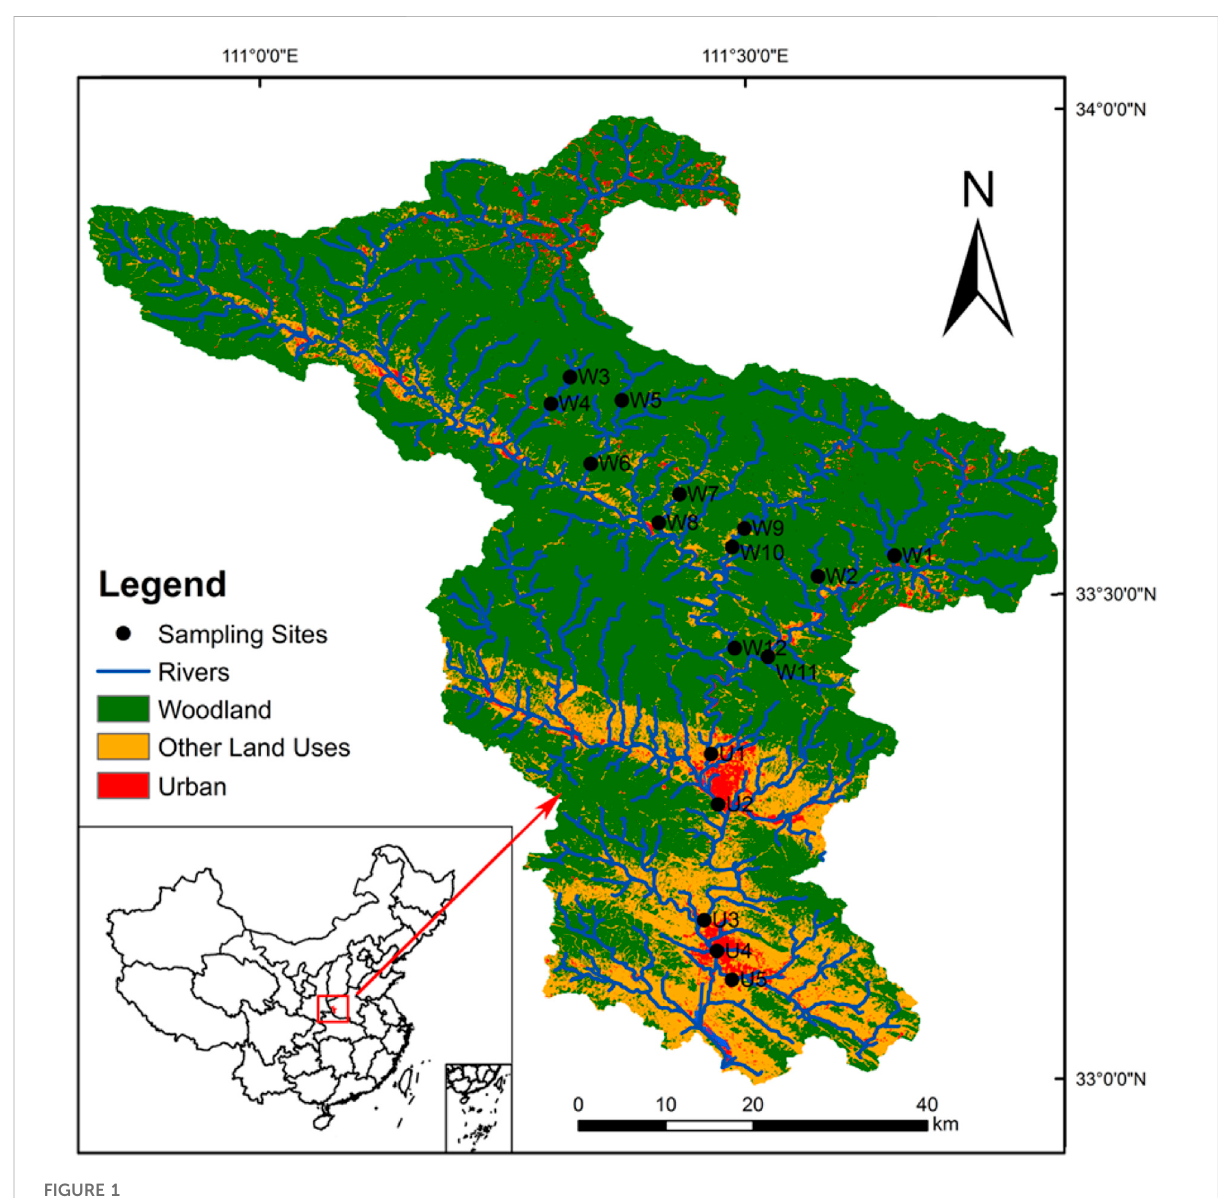
FIGURE 1 Locations of the sampling sites in the Laoguan